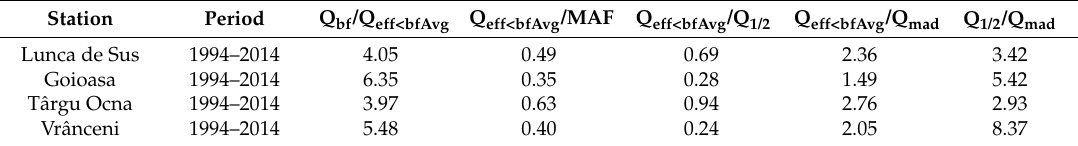
Table 7. Ratios of parameters